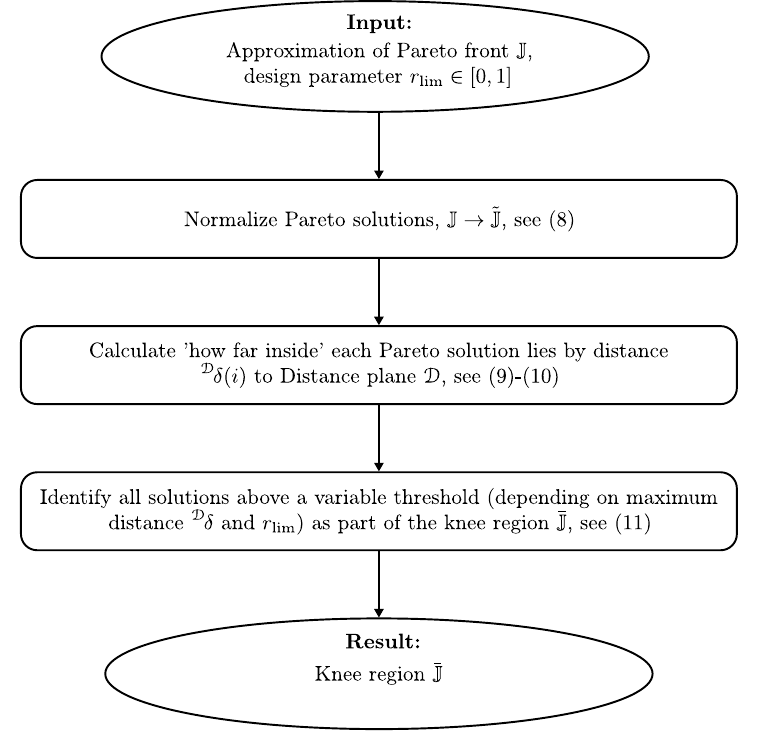
Figure 3. Flowchart diagram for the first step of the proposed decision making approach, i.e., the determination of the knee region.